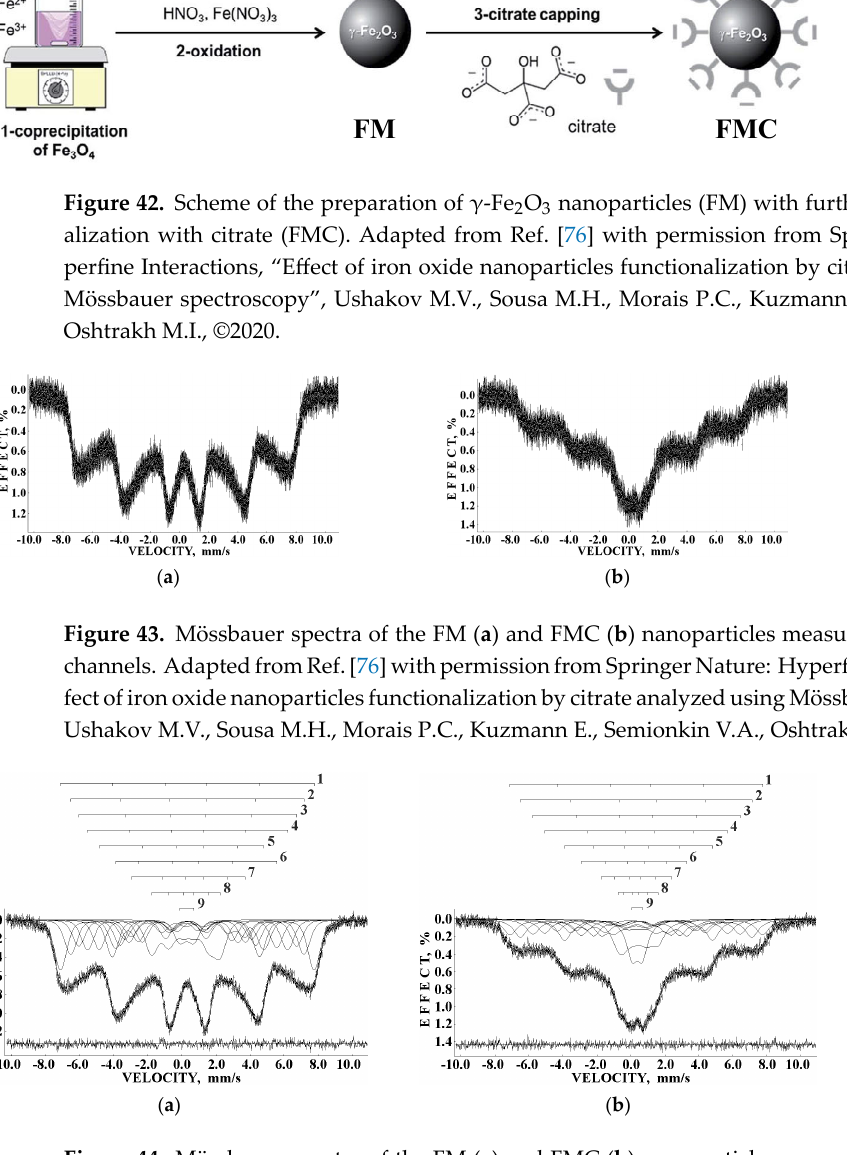
Figure 42. Scheme of the preparation of γ‐ Fe 2 O 3 nanoparticles (FM) with further surface function ‐ alization with citrate (FMC). Adapted from Ref. [76] with permission from Springer Nature: Hy ‐ perfine Interactions, “Effect of iron oxide nanoparticles functionalization by citrate analyzed using Mössbauer spectroscopy”, Ushakov M.V., Sousa M.H., Morais P.C., Kuzmann E., Semionkin V.A., Oshtrakh M.I., ©2020.